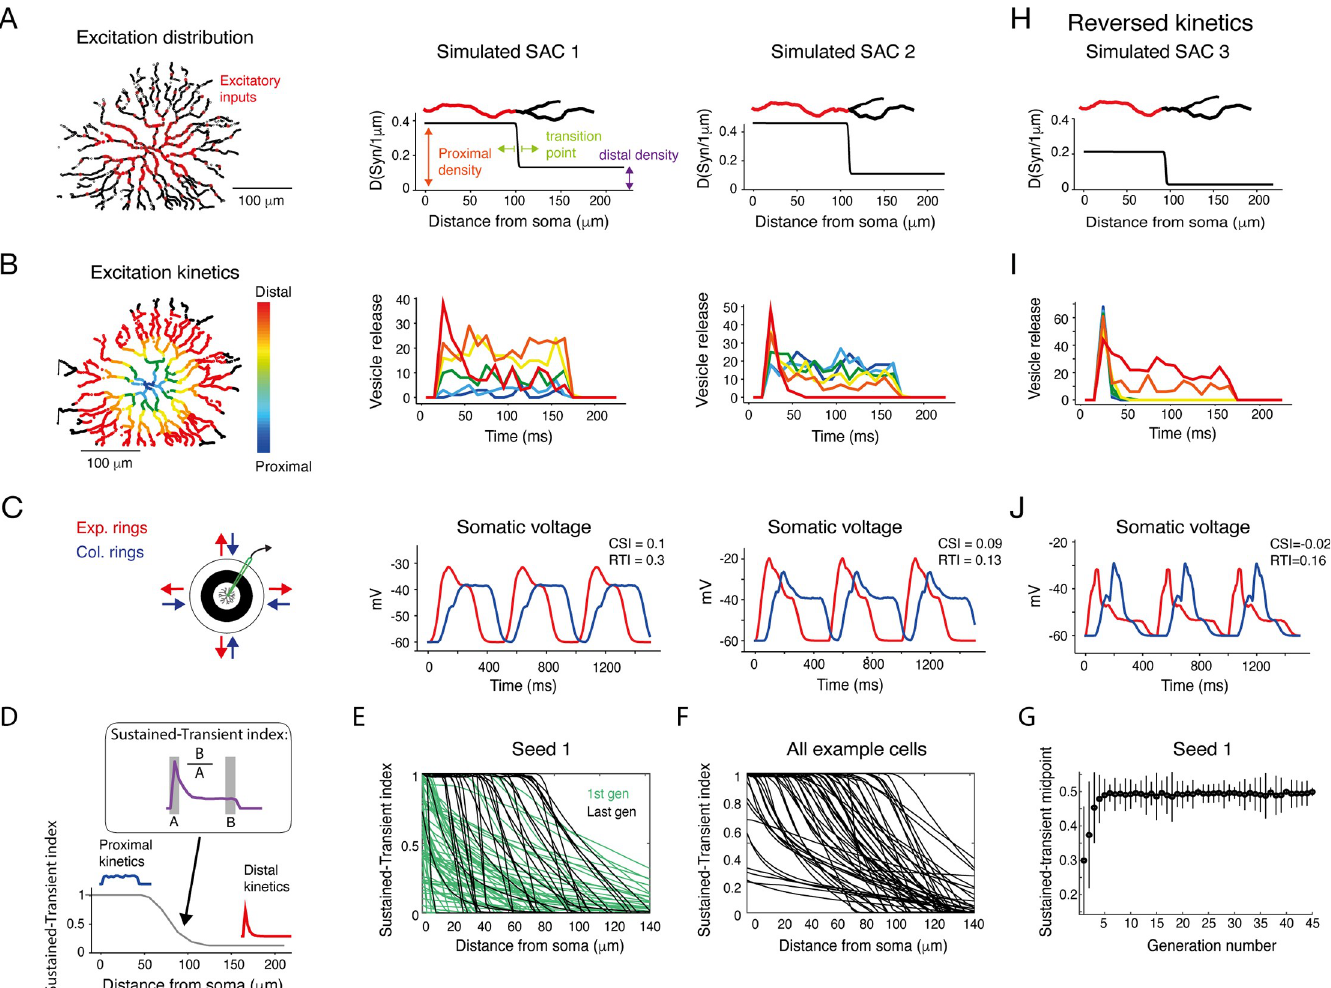
Fig 3. Kinetic properties of excitatory inputs can generate CF preference in simulated SACs. A. Left: Reconstruction of a SAC showing the spatially restricted simulated excitatory inputs (red dots). Right: Density of excitatory synapses as a function of distance from soma for two example simulated SACs. The distribution is set by three parameters: proximal synapse density, distal synapse density and the anatomical transition point. For illustration, the transition of color in the example process on top depicts the location of the anatomical transition point. B. Left: Illustration of the spatiotemporally diverse excitation distribution, color-coded according to distance from the SAC soma. Right: The kinetics of excitatory inputs in different locations along SAC processes are color-coded by their distance from the cell soma for the two example simulated SACs. C. Left: Illustration of the stimulus. Right: The somatic voltage of the two simulated SACs in response to expanding (red) and collapsing (blue) rings. D. The sustained-transient index of the excitatory inputs was calculated at each dendritic location based on the input kinetic waveform (see inset and Methods ). Values of 1 and 0 indicate completely sustained and transient input kinetics, respectively. E. The sustained-transient index as a function of distance from cell soma for all cells in the first generation (light green) and last generation (#45; dark green) of an example simulation seed. F. Same as E , for all example cells shown in Fig 5C and 5E . G. The midpoint of the sustained-transient index for all cells in the example seed as a function of generation. By the 6 th generation, the indices tend to span the entire range–from 1 in the proximal to 0 in the distal processes–and the index converges on a value of 0.5. H-J. As in A-C but for an example SAC with reversed kinetics of the excitatory inputs, changing from transient inputs in the proximal to sustained inputs in the distal